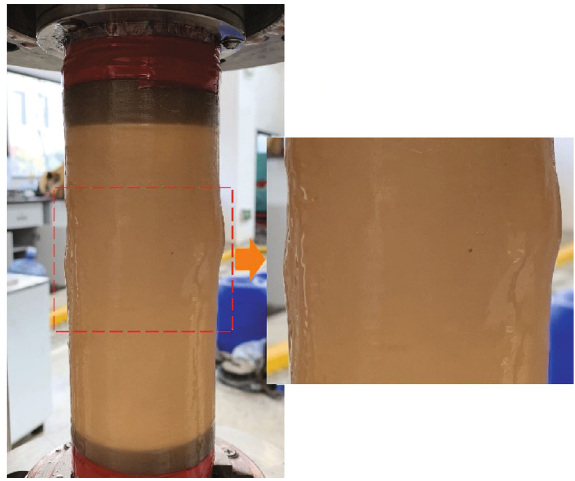
Figure 18: Ice sample frozen with two freezing fronts developing towards each other. The middle expansion is shown with double magni fi cation.